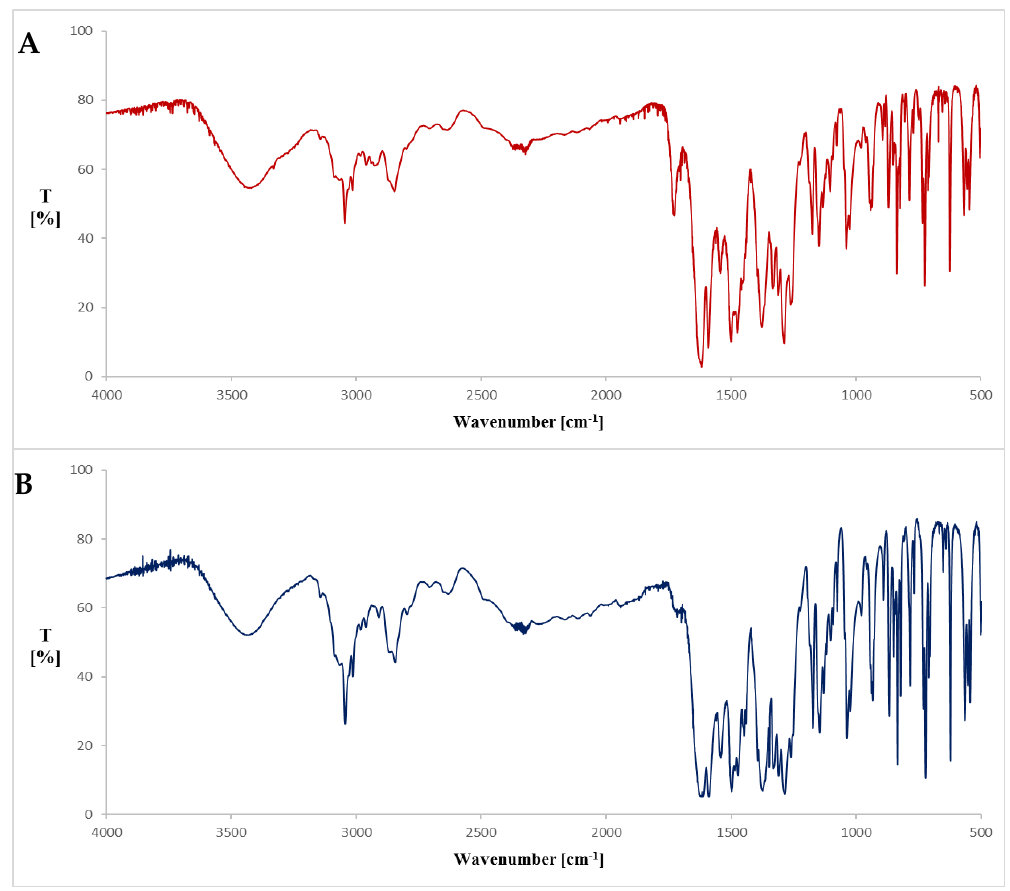
Figure 1. FT-IR spectra of precipitate ( A ) and reference sample of CF ( B ).